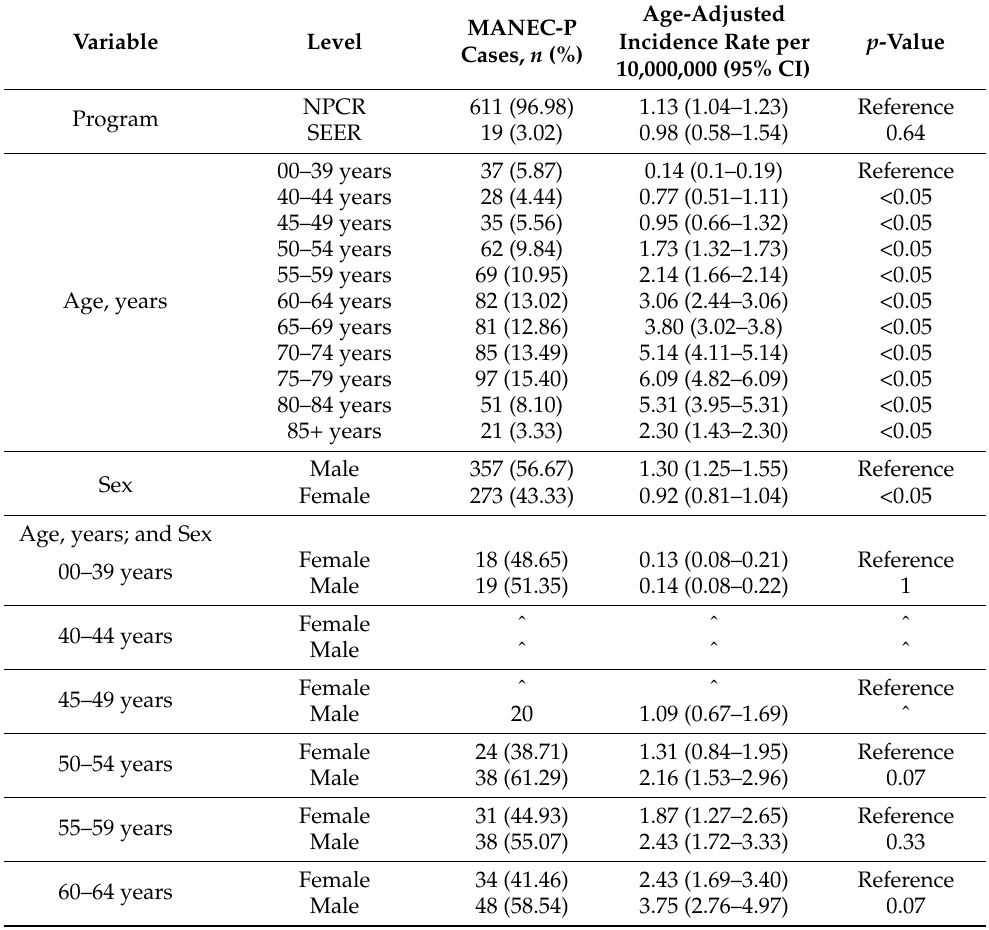
Table 1. MANEC-P Incidence Rate by demographics, tumor characteristics and temporal trend. Variable Level